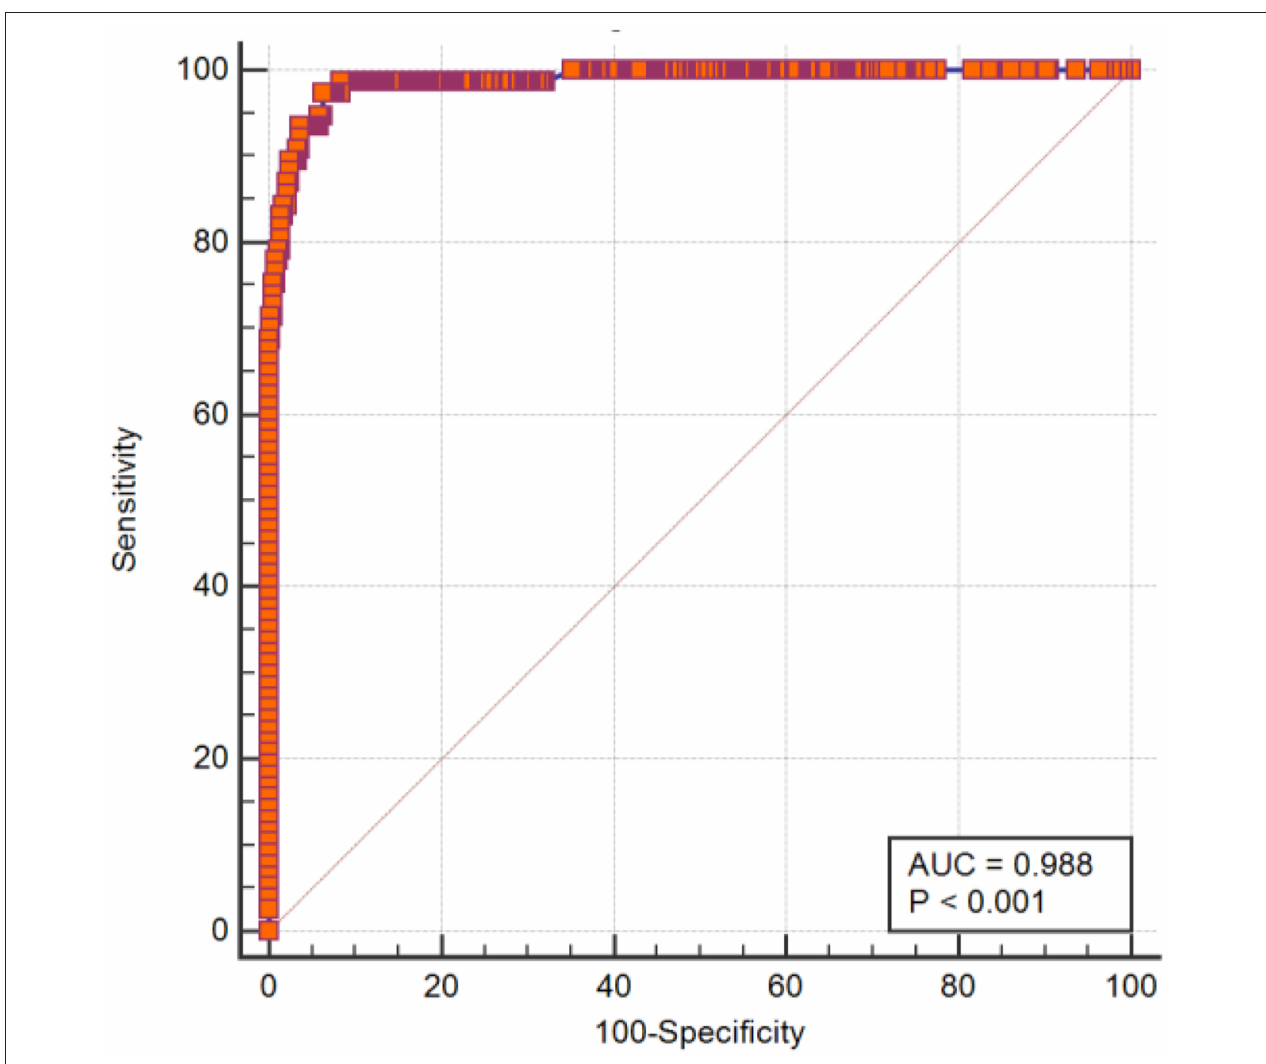
FIGURE 1 | ROC curve of the postoperative delirium prediction model for type A aortic dissection.